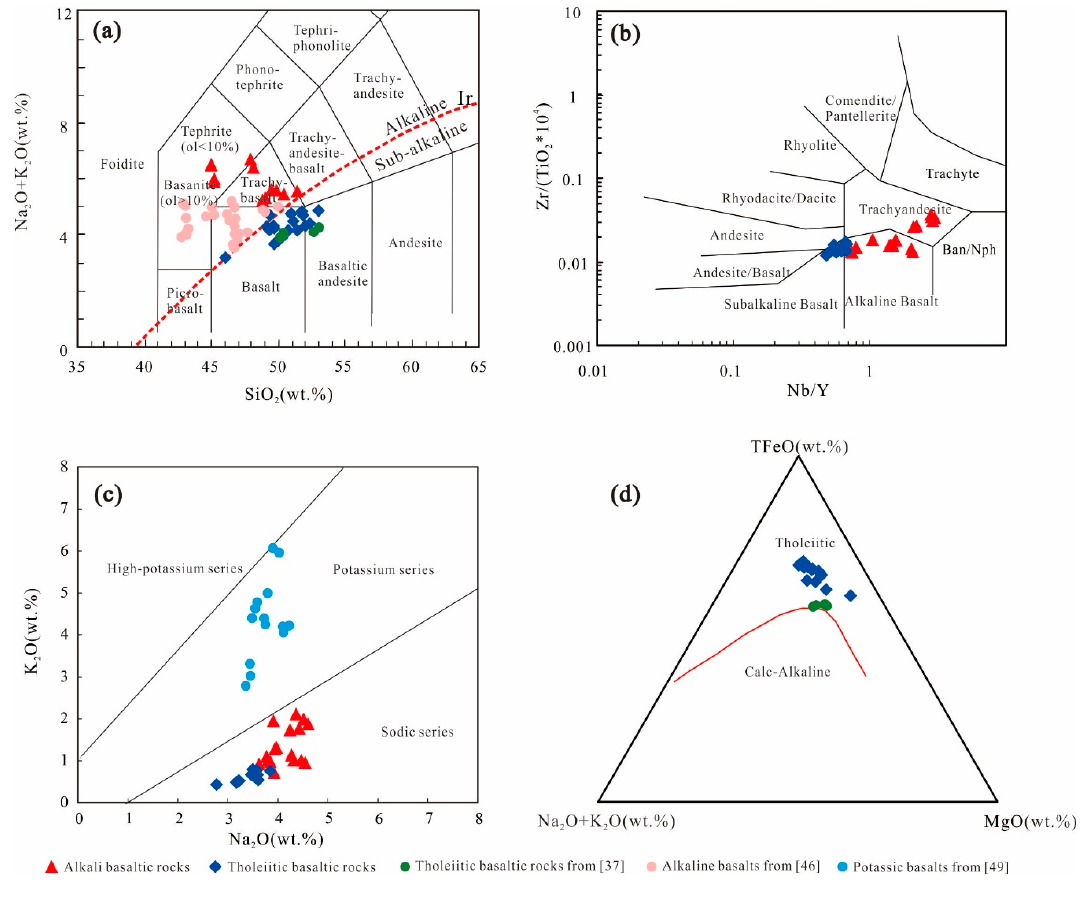
Figure 6. Plots of ( a ) Na 2 O + K 2 O vs. SiO 2 (after Irvine and Baragar [47]), ( b ) Zr / (TiO 2 × 10 − 4 ) vs. Nb / Y (after Winchester and Floyd [48]), ( c ) K 2 O (wt.%) versus Na 2 O (wt.%) [49], and ( d ) TFeO-Na 2 O + K 2 O-MgO triangular diagram, the boundary line between alkaline series and the tholeiitic series after Irvine and Baragar [47], A = Na 2 O + K 2 O (wt.%); F = T FeO (wt.%); M = MgO (wt.%). The chemical data